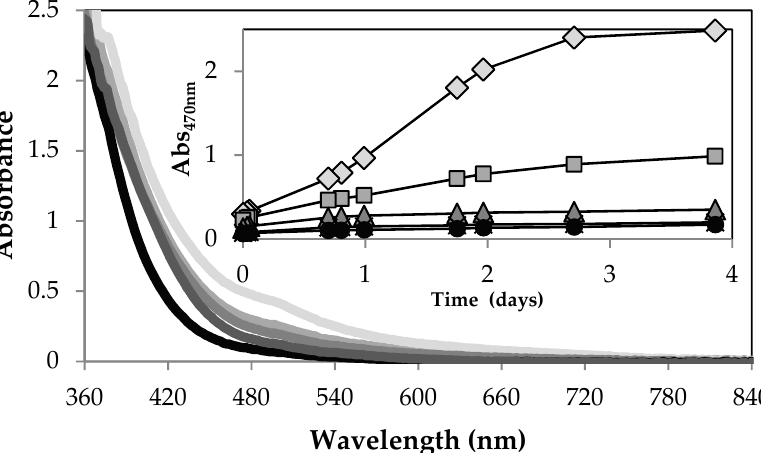
Figure 2. UV/Vis spectra of green tea recorded 14 h after preparation with synthetic freshwater of different hardness from very hard (light grey line) to very soft (black line). The tea brand was Lipton green tea purchased in Fall 2017. Insert: Absorbance increase at 470 nm for tea samples prepared with very soft (black circle), soft (black cross), moderately hard (grey triangle), hard (grey square), to very hard (light grey diamond) water.